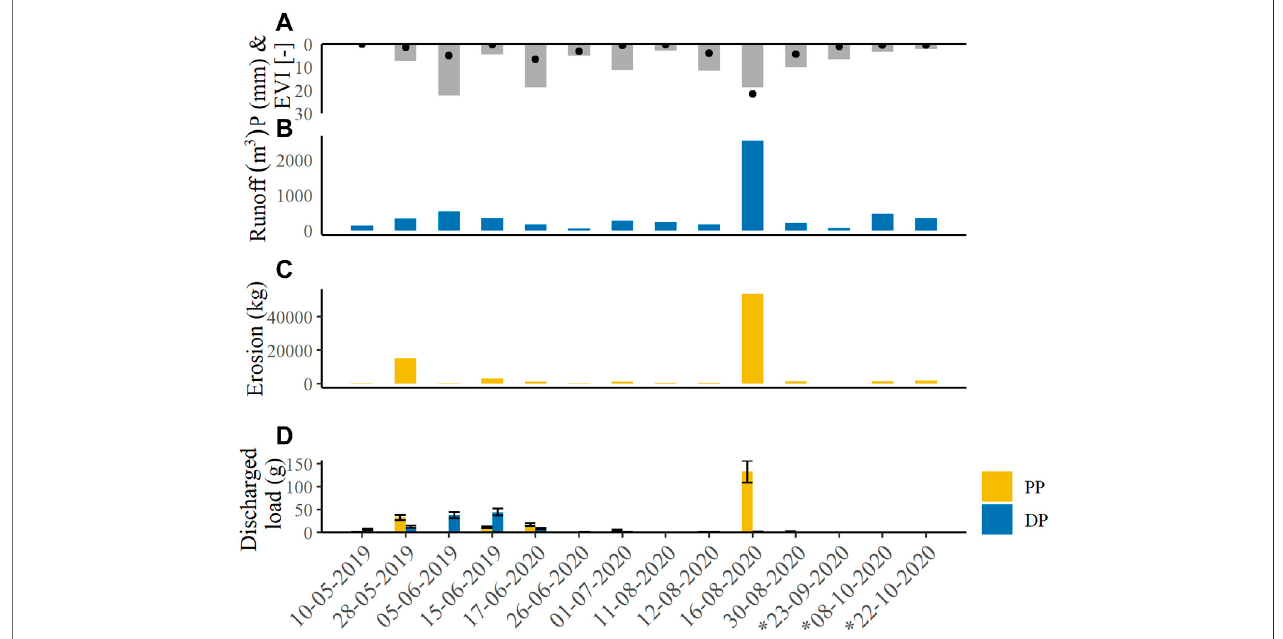
FIGURE 2 | Overview of rainfall (A) , runoff (B) , related erosion (C) and total pesticides transported (g) by particulate (PP) and dissolved phase (DP) (D) for the 14 events measured in 2019 and 2020. Error bars indicate uncertainty of total value (±18% PP and ±17% DP, see Section 2.5 ).